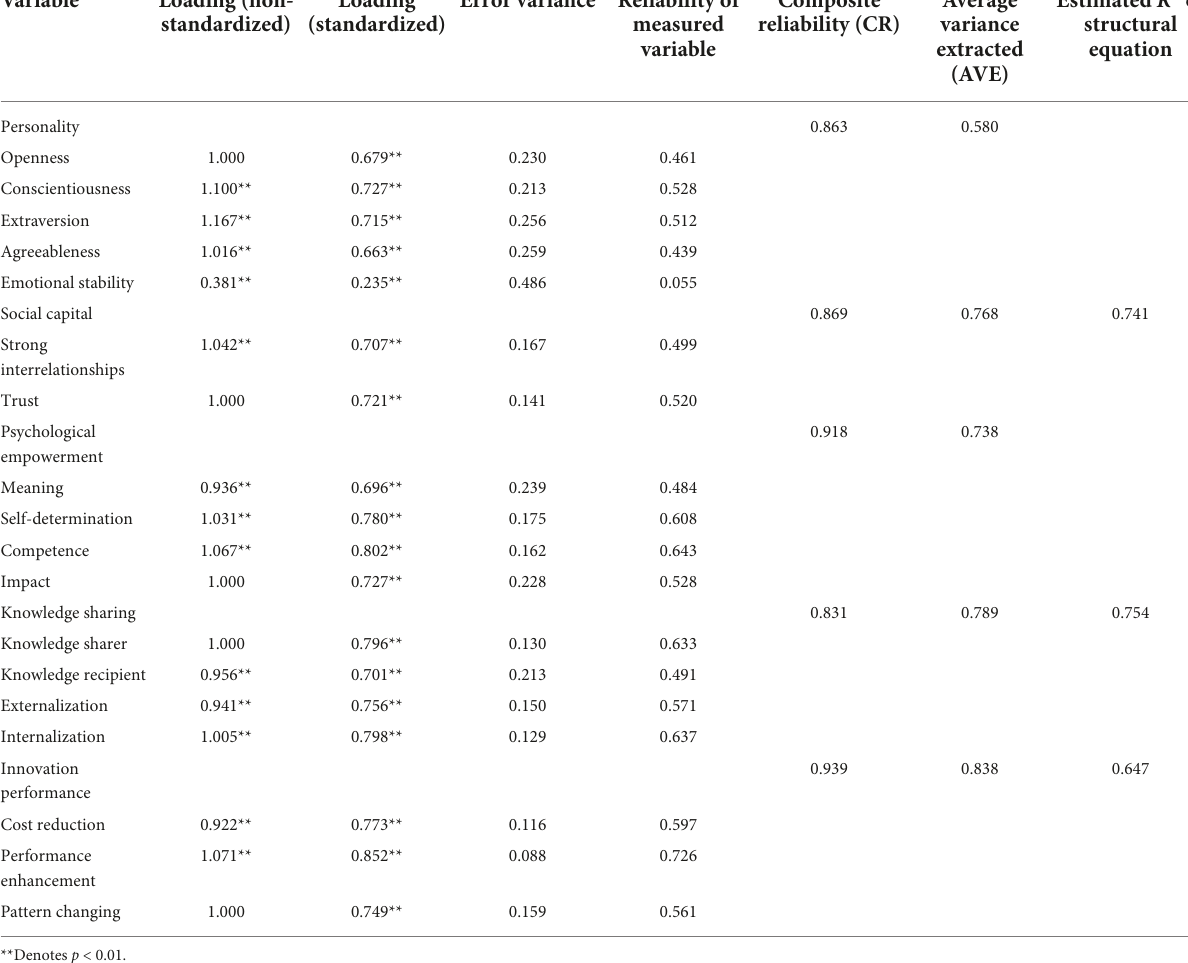
TABLE 3 Analysis of the scale’s reliability, loading, and variance extracted, and structural modeling estimation results.